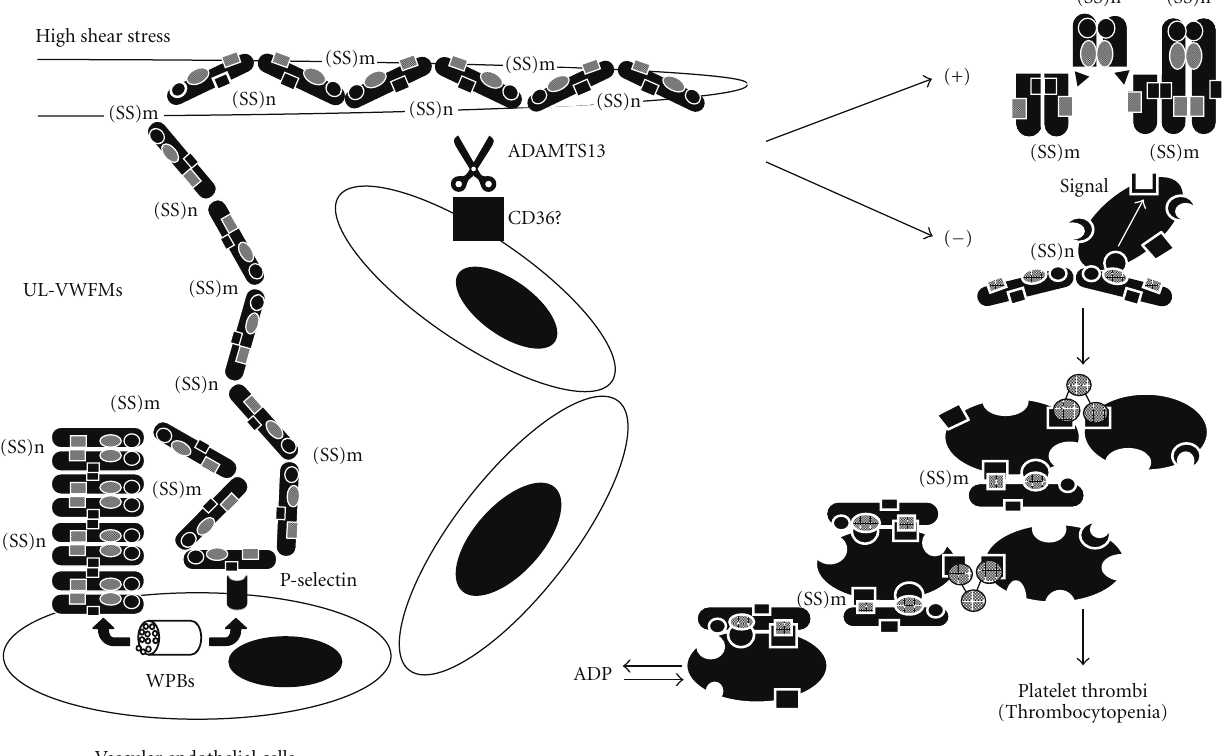
Figure 1: Proposed mechanism of platelet thrombi under high shear stress in the absence of ADAMTS13:AC. Unusually large von Willebrand factor multimers (UL-VWFMs) are produced in vascular endothelial cells (ECs) and stored in Weidel-palade bodies (WPBs). UL-VWFMs are released from WPBs into the circulation upon stimulation by cytokines, hypoxia, DDAVP, and epinephrine. P-selectin that comigrates from WPBs anchors UL-VWFMs on the vascular EC surface. Under these circumstances, high shear stress changed the molecular conformation of UL-VWFMs from a globular to an extended form, allowing ADAMTS13 to access this molecule. In the absence of ADAMTS13: AC, UL-VWFMs remain uncleaved, allowing them to excessively interact with platelet glycoprotein (GP)Ib α and activate platelets via intraplatelet signaling, which result in the formation of platelet thrombi. (Partially modified from Fujimura et al.,